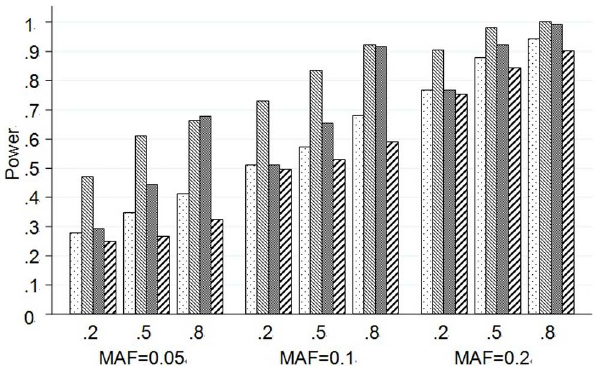
Figure 2. Test powers at two causal SNPs model based on 10 SNPs. The plot shows the powers (y-axis) of each method over the different LD and MAF structures (x-axis). The first line of x-axis represents LD, and the bottom line is MAF.